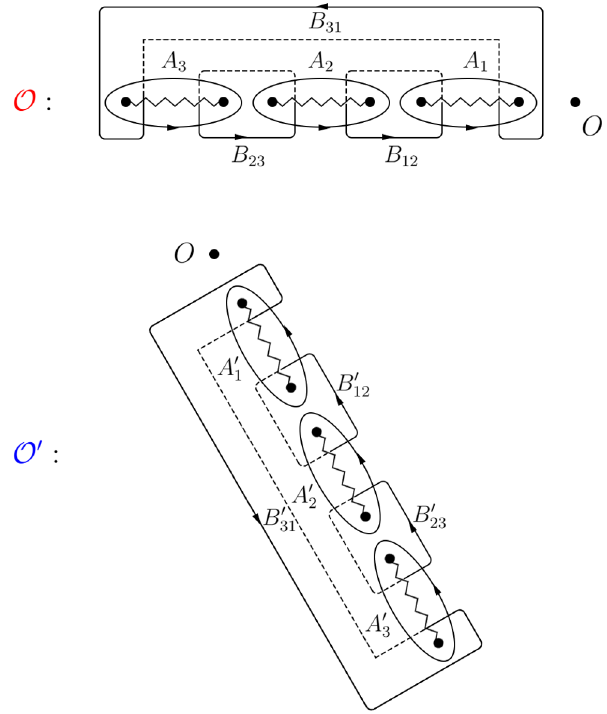
Figure 14 . The local branch cuts and choices of 1-cycles on t 2 -plane for the observers O